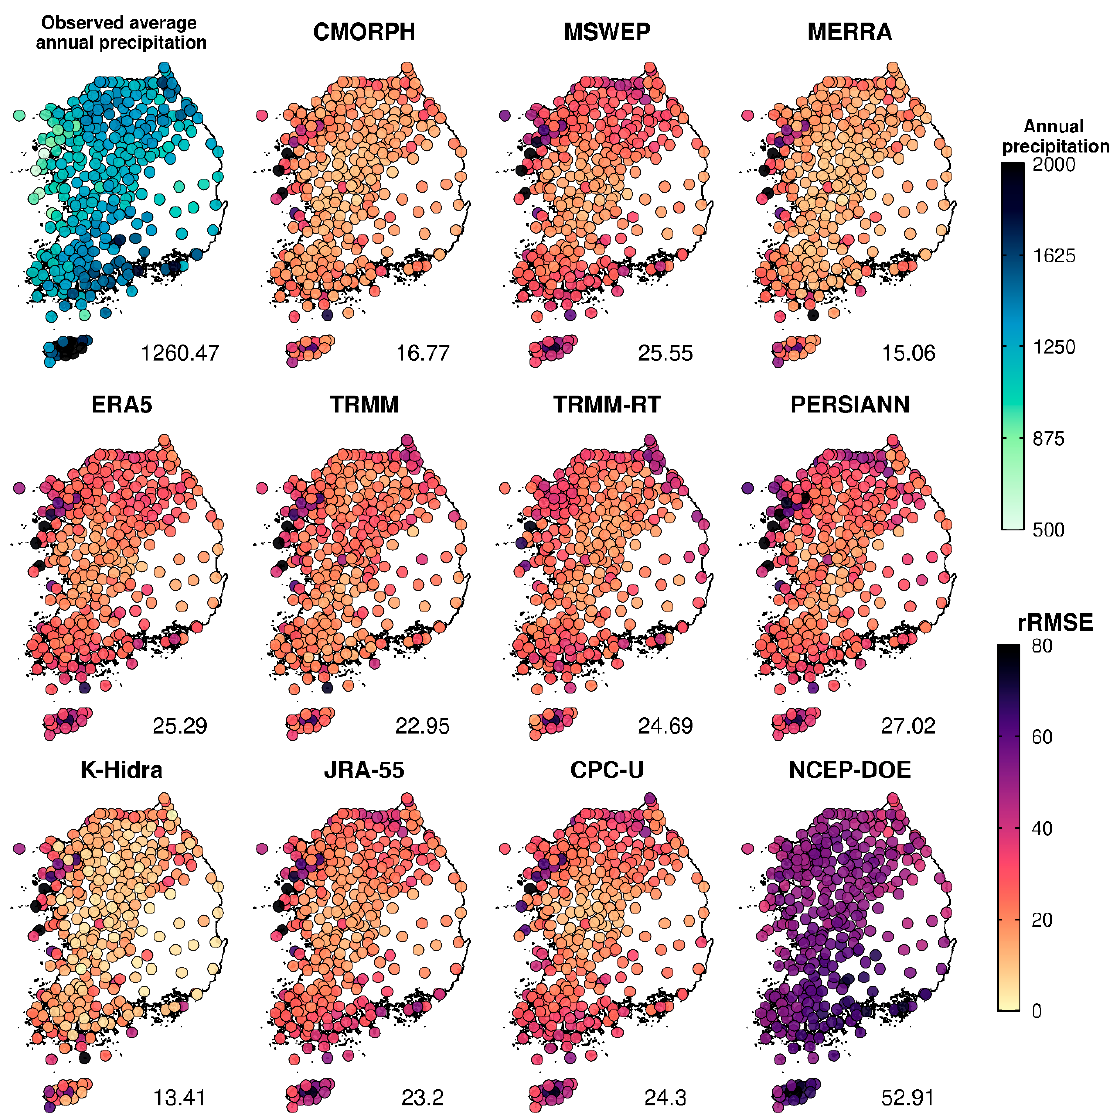
Figure 2. Spatial patterns of rRMSE for annual precipitation of the grid datasets from observations. The median values of rRMSE metric across 356 stations are also presented for each sub-figure.